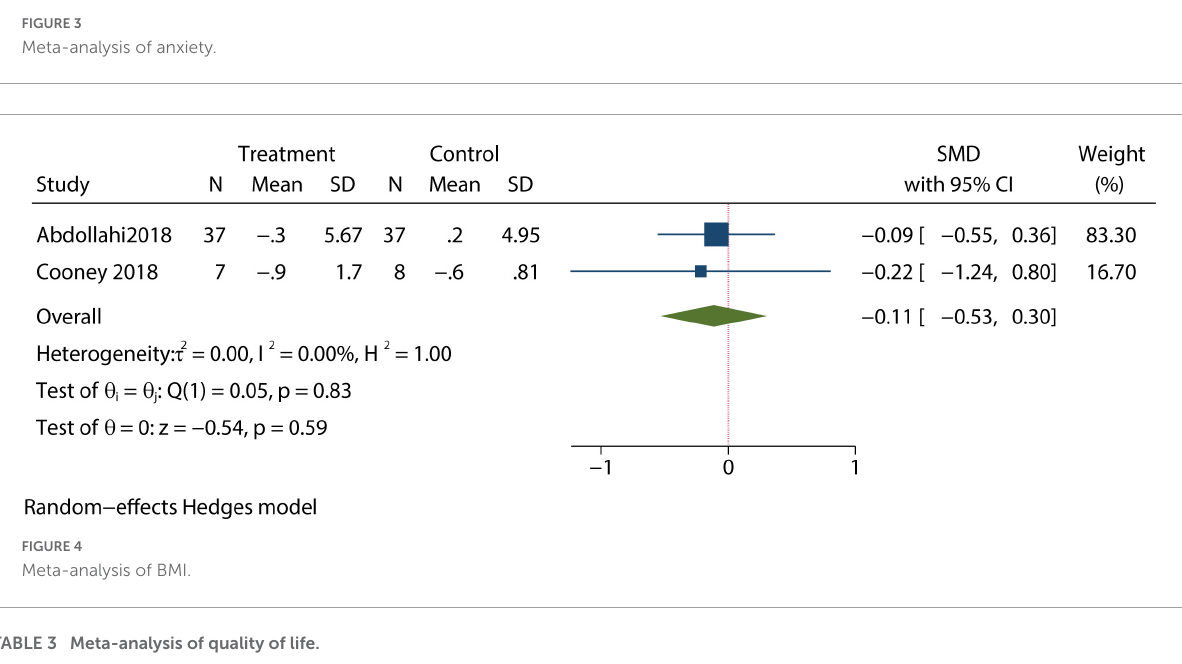
TABLE 3 Meta-analysis of quality of